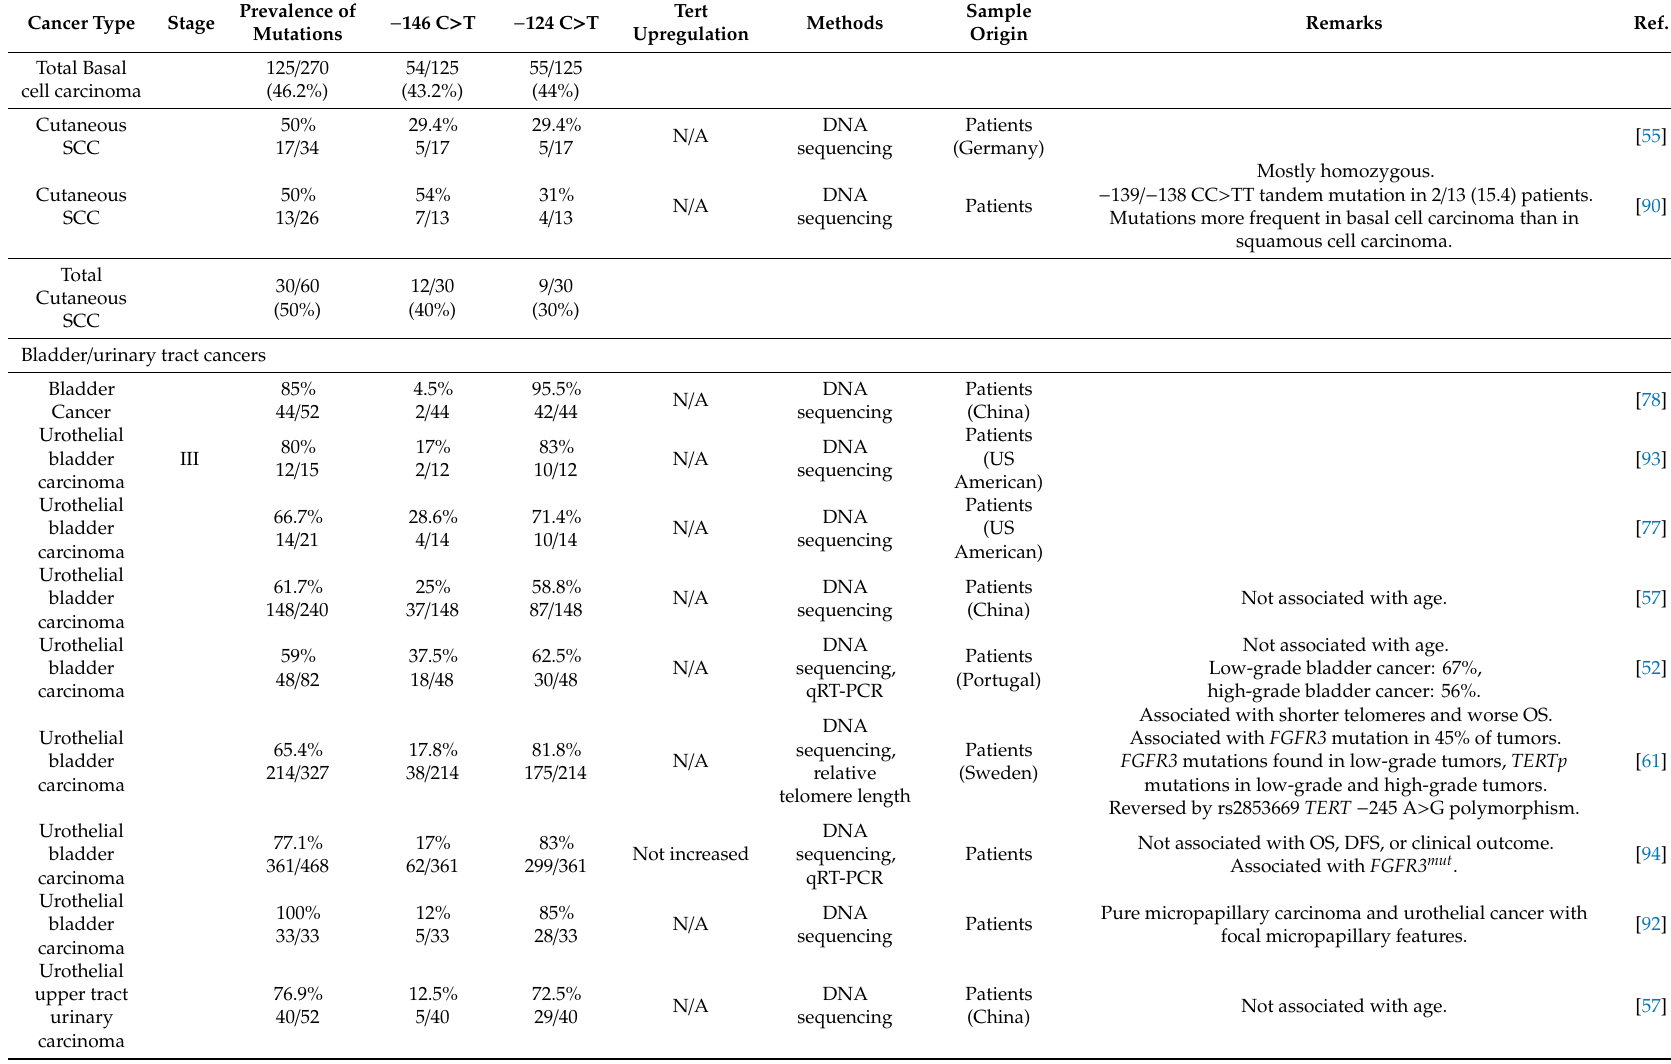
Mostly homozygous. − 139 / − 138 CC > TT tandem mutation in 2 / 13 (15.4) patients. DNA Patients sequencing